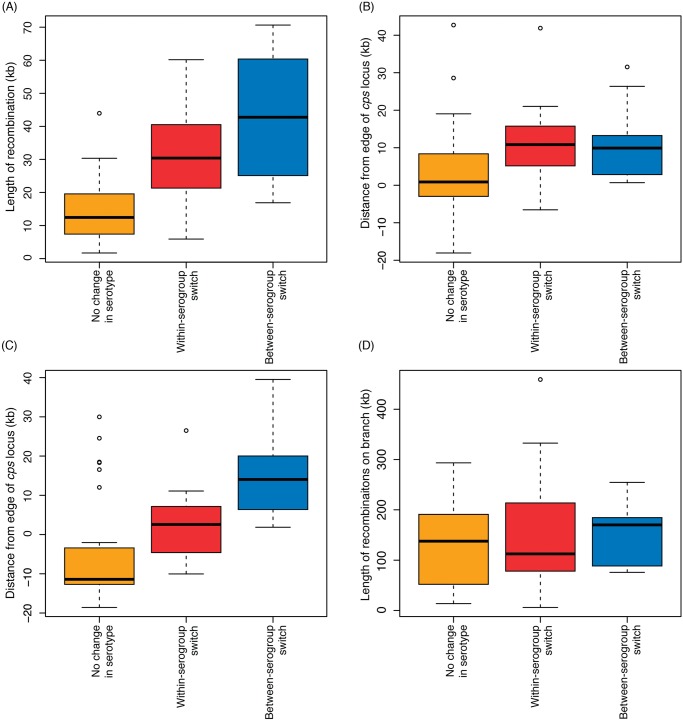
Properties of recombinations affecting the cps locus.In each boxplot, the recombinations affecting the cps locus are grouped according to their inferred impact on serotype. The first three graphs describe the recombinations affecting the cps locus. The values represent (A) overall length of recombination, (B) position of the 5’ edge of the recombination relative to the 5’ edge of the cps locus, and (C) position of the 3’ edge of the recombination relative to the 3’ edge of the cps locus. In the latter two plots, negative values indicate the recombination boundary is within the cps locus. The boxplot in (D) represents the total length of genome-wide recombinations on the same phylogenetic branch as the serotype switching events.